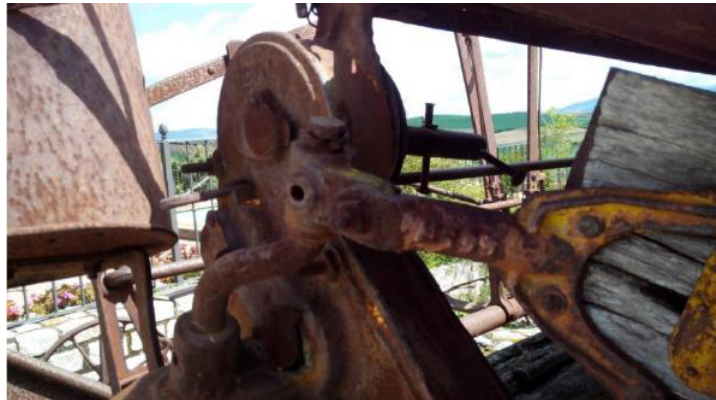
Figure 20. Connecting rod/crank mechanism in the sheaf system.